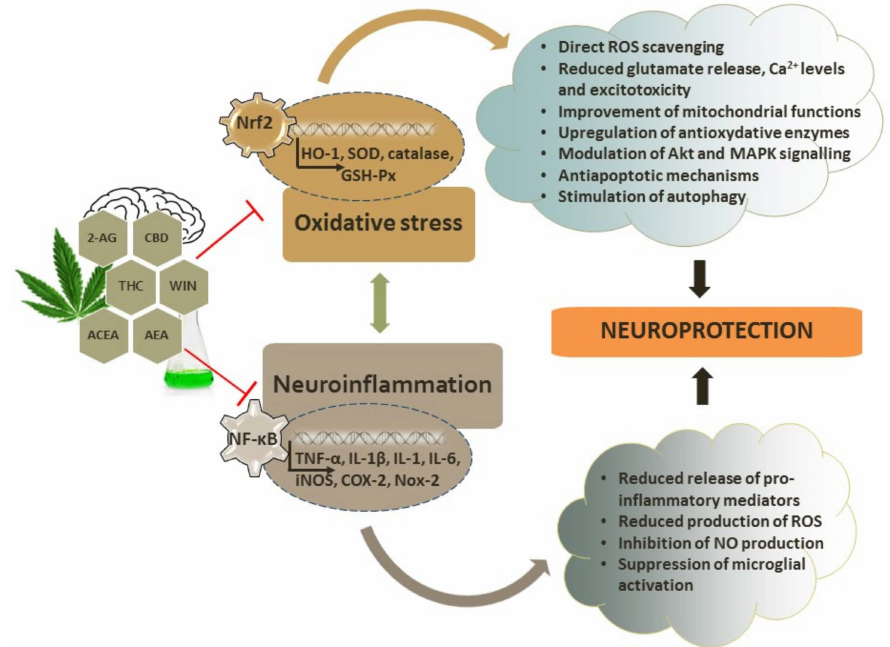
Figure 2. Antioxidative and anti-inflammatory effects of cannabinoids. ACEA—arachidonoyl-2-